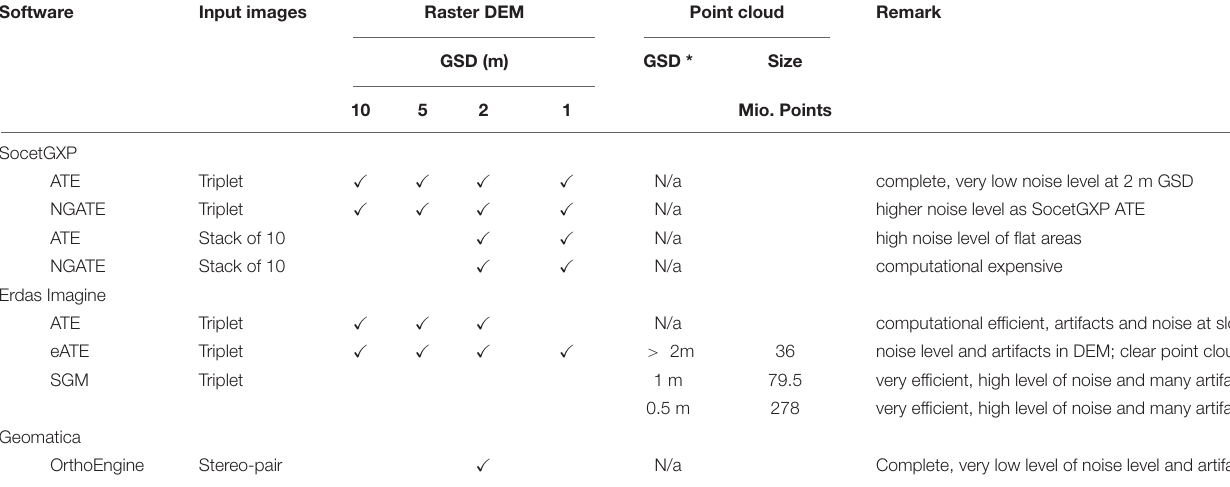
TABLE 3 | Overview of Terrain matching experiments.